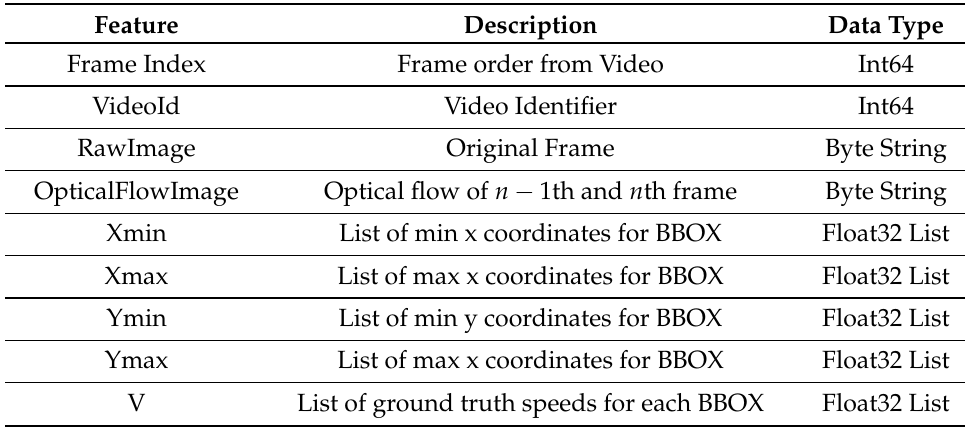
Figure 2. A sample optical flow image. Table 2. Features of the dataset.